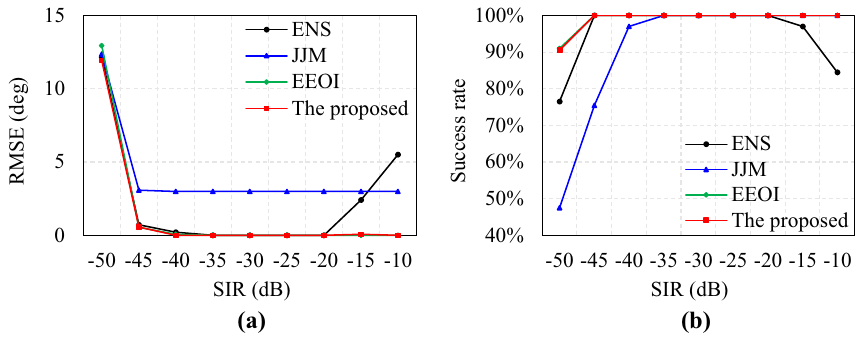
Fig. 5 RMSE or success rate of DOA estimation versus different SIRs. a RMSE. b Success rate